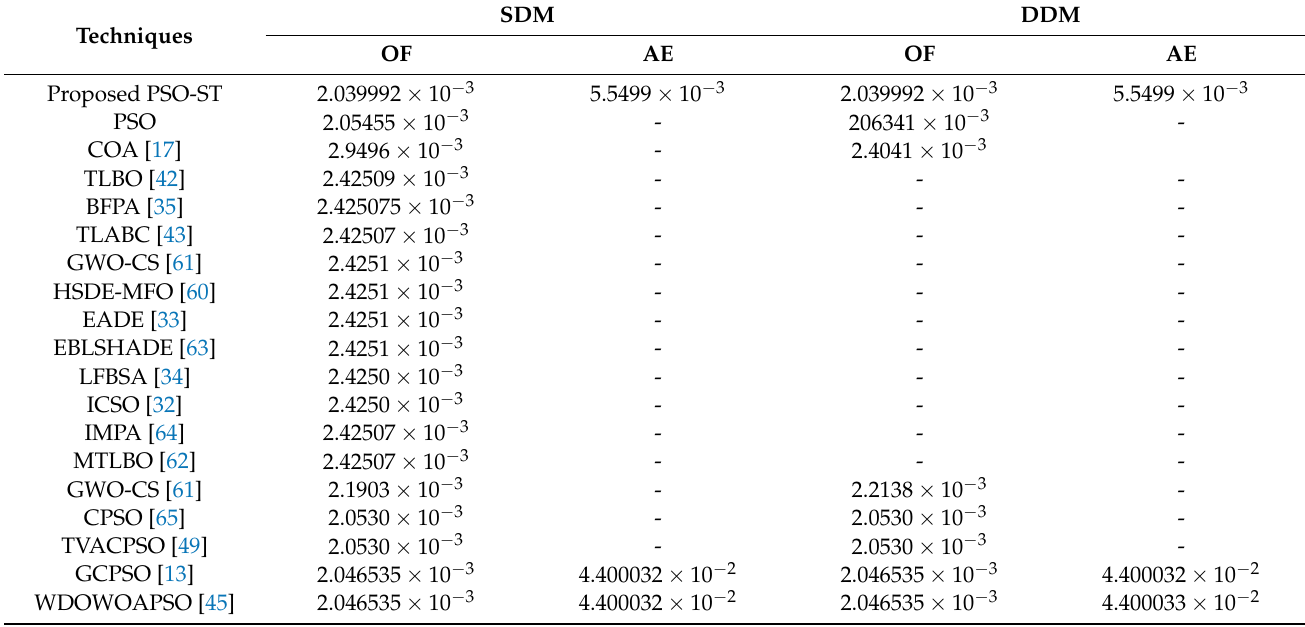
Table 9. Obtained optimal results and its comparison with literature available techniques proposed technique for SDM and DDM PV module. (- indicates not provided by